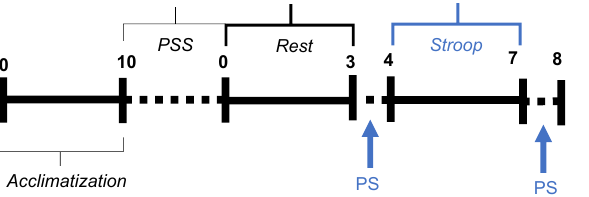
Figure 1. Protocol timeline. The dashed line indicates that the subject may take as much time as he/she needs to complete the task. PS indicates the moment when the subject is asked to report its perceived stress